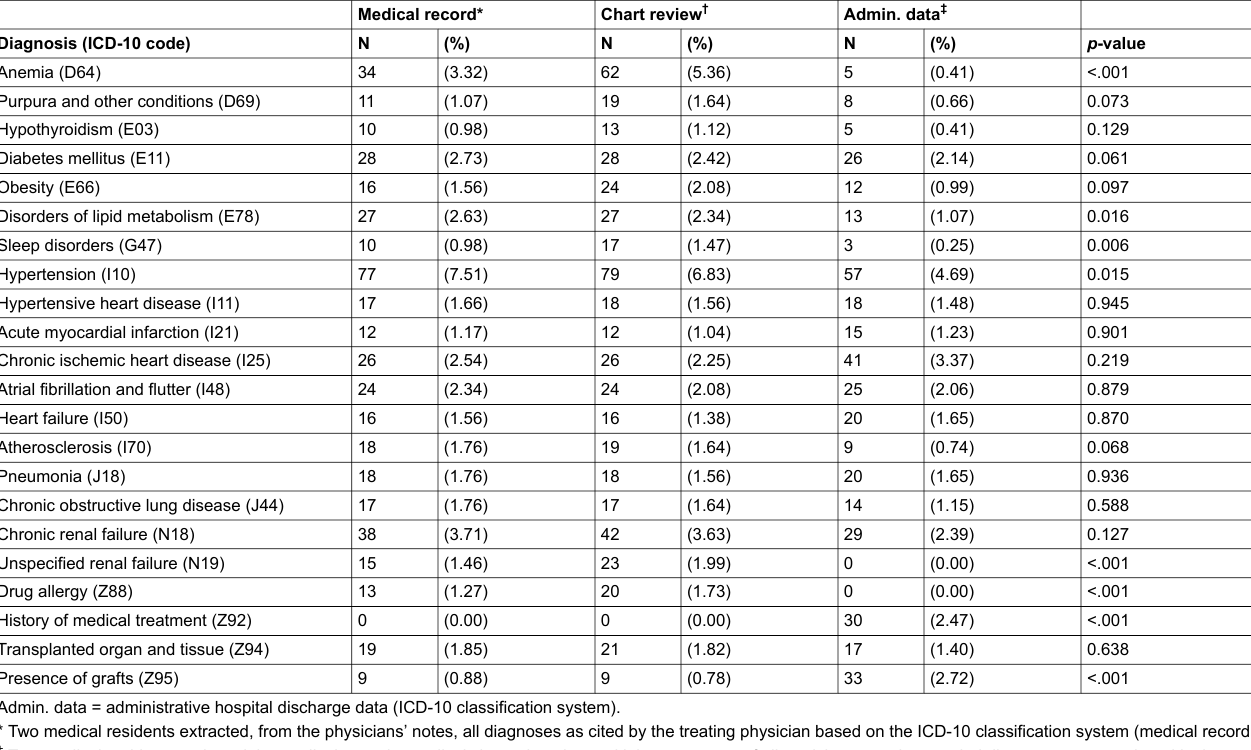
Table 2: Frequency (count, [%]) of common diagnoses extracted from three different data sources (medical record, chart review, administrative data).